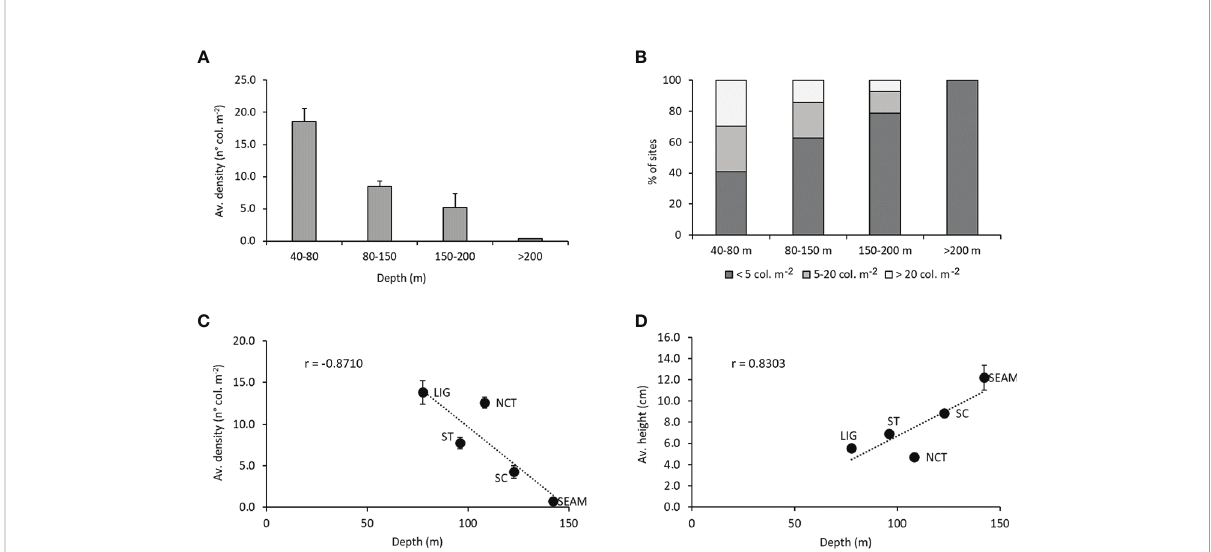
FIGURE 5 Bathymetric and latitudinal effect. (A) Relationship between average density (± SE) of the populations and depth in the four considered depth ranges. (B) Percentage of sites with scattered populations (dark grey), dense populations (grey), and very dense populations (light grey) in the four depth ranges. (C) Correlation between average density (± SE) of the populations grouped per macro-area and depth. (D) Correlation between average height (± SE) of the populations grouped per macro-area and depth.